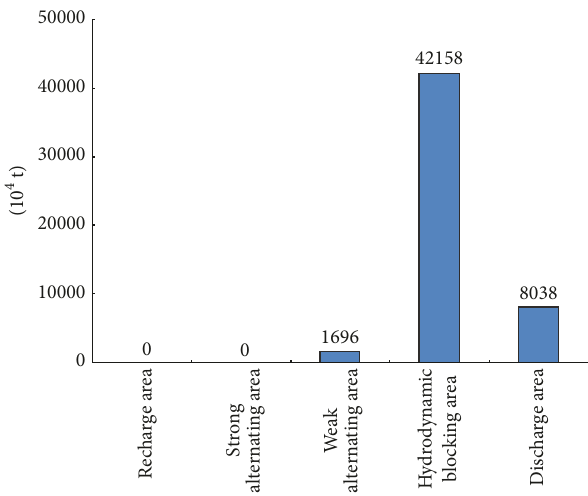
Figure 13: Proven oil reserves in different hydrodynamic systems of buried hill, Jizhong